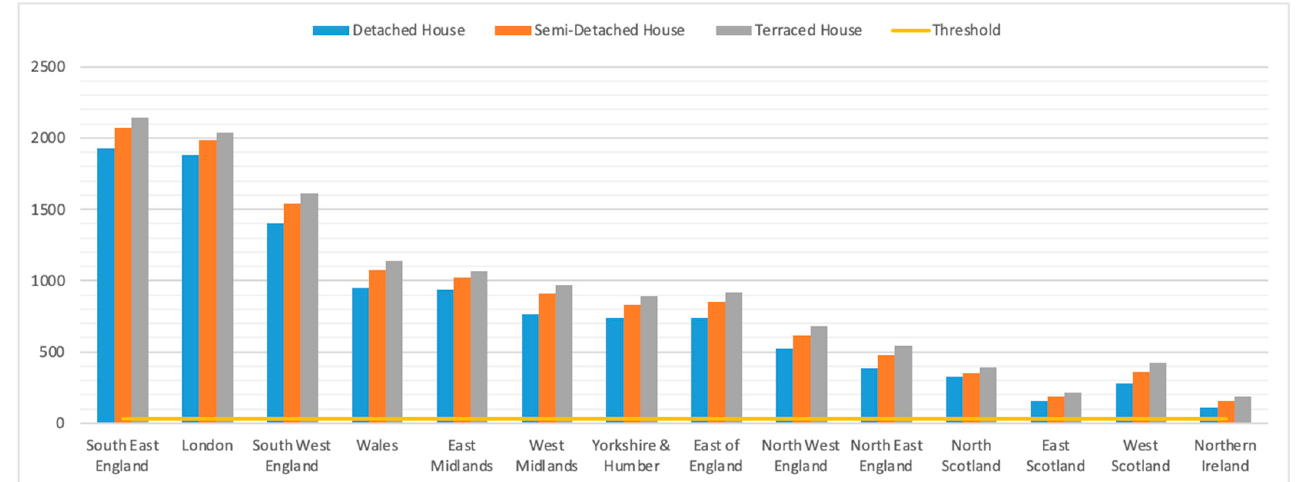
Figure 9. Base model annual bedroom overheating with PROMETHEUS 2080s, medium emissions climate data; line shows 32 h overheating threshold.